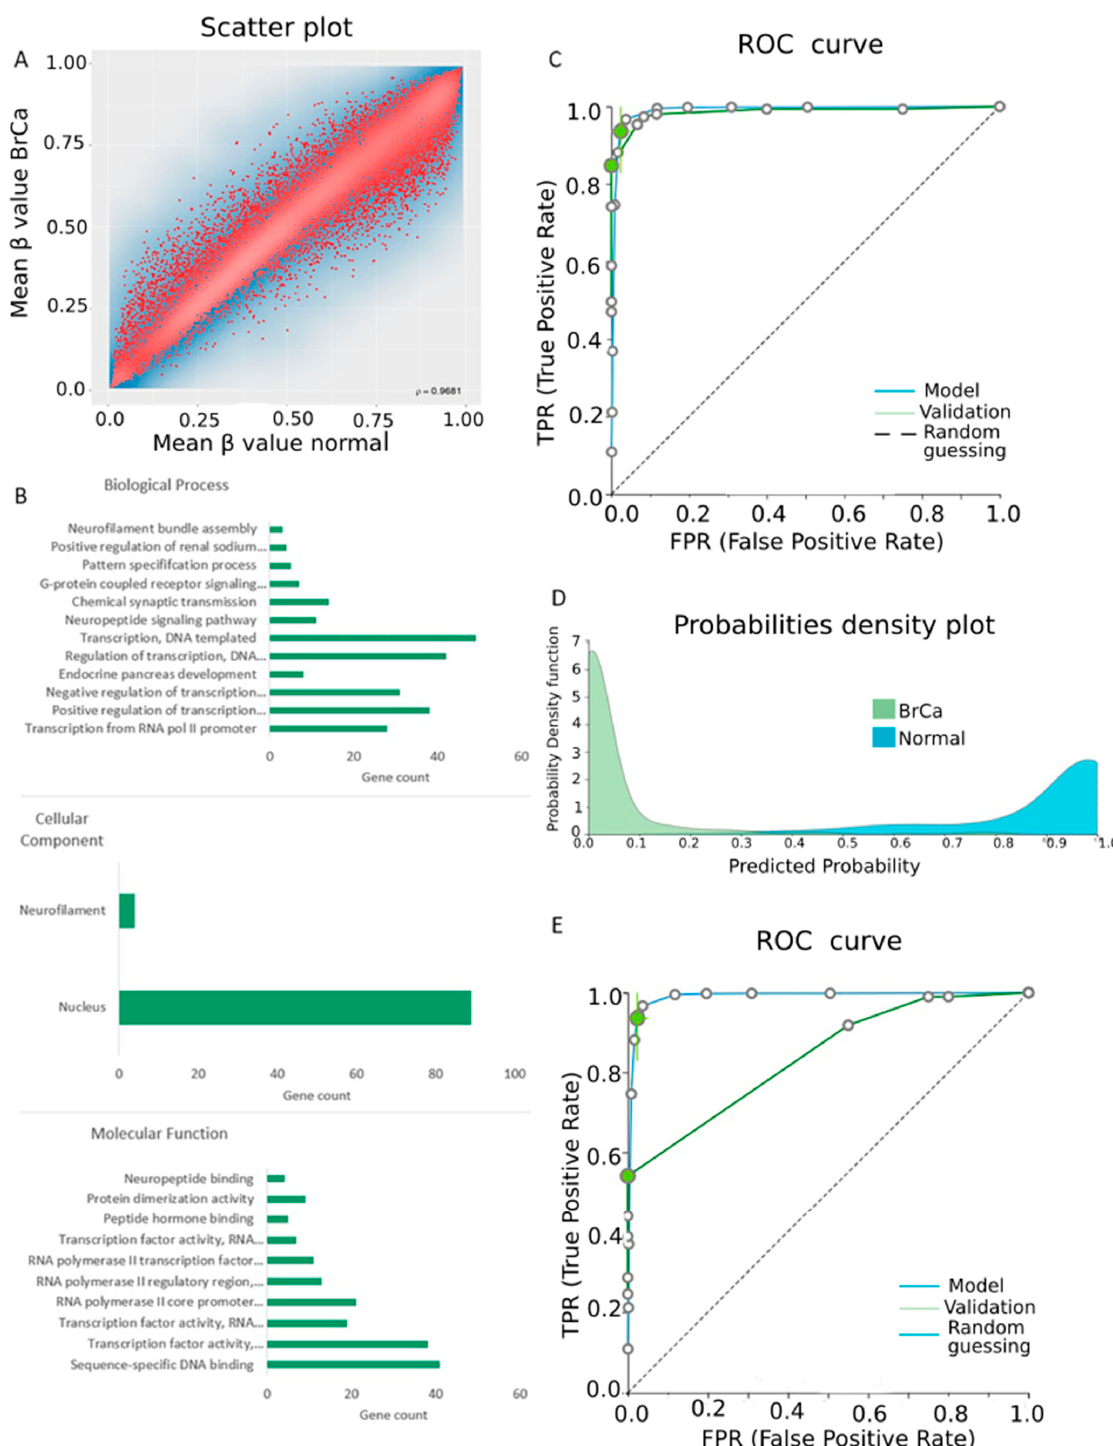
Figure 2. Differential methylation between breast cancer (BrCa) and normal breast tissue. ( A ) A scatterplot showing the mean β value for each gene among BrCa and normal tissues. ( B ) The gene ontology analysis of top 250 differentially methylated genes (DMGs) in the aspects of molecular function, biological process and cellular component analysis. ( C ) Receiver operating characteristic (ROC) curves of training (blue line) and validation (green line) models. ( D ) Probability density plot depicts discrete distributions among studied classes of the training group. ( E ) ROC curves of training (blue line) and external validation (green line) models. Abbreviations: BrCa = breast cancer, DMGs = differentially methylated genes, ROC = receiver operating